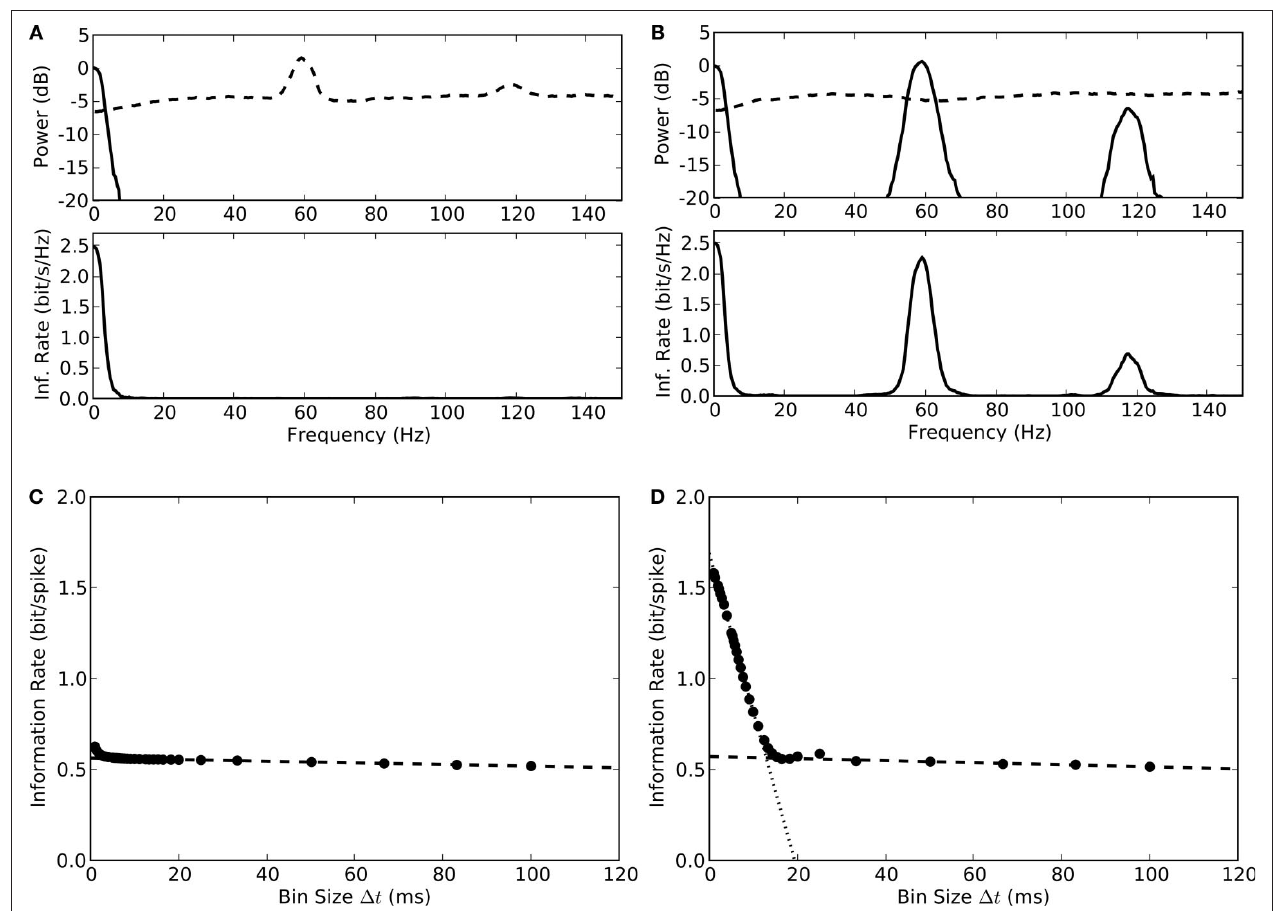
spectrum (top, dashed line) and information estimate (bottom). (C) Information estimate with oscillation phase randomized across trials (0.6 bit/ spike). (D) Information estimate with oscillation phase aligned across trials increases from 0.6 bit/spike to 1.8 bit/spike if small bin width ( < 20 ms) are taken into